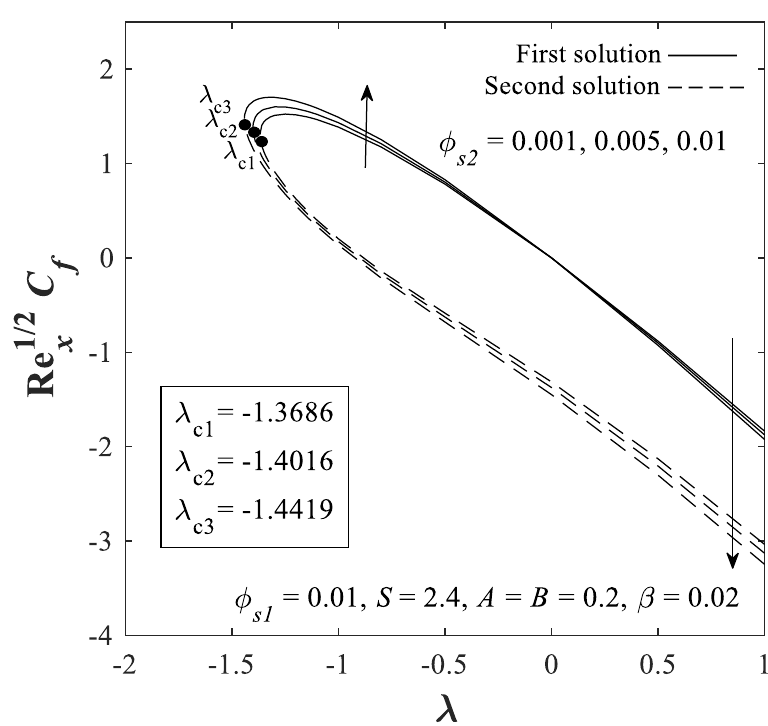
Figure 5. Plot of  1/2 Re